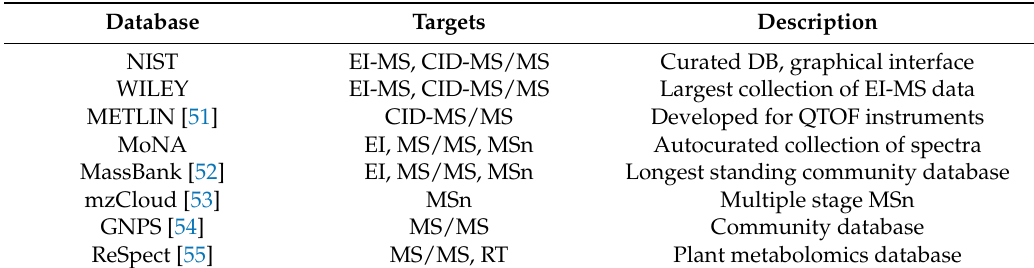
Table 3. Overview of selected mass spectral databases commonly used for compound annotations. Specialized reviews that cover other mass spectral databases are referenced in the